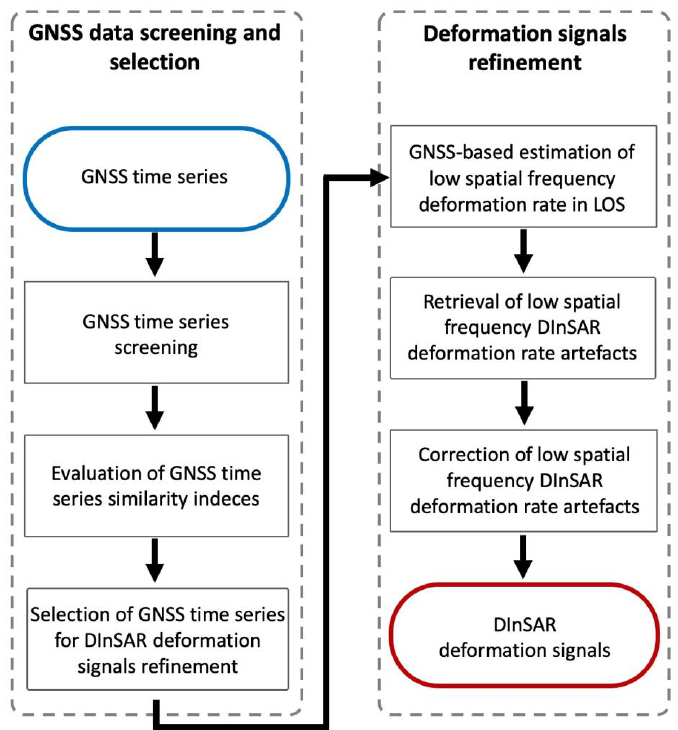
Figure 3. Block diagram of the proposed procedure for the DInSAR deformation signals refinement.